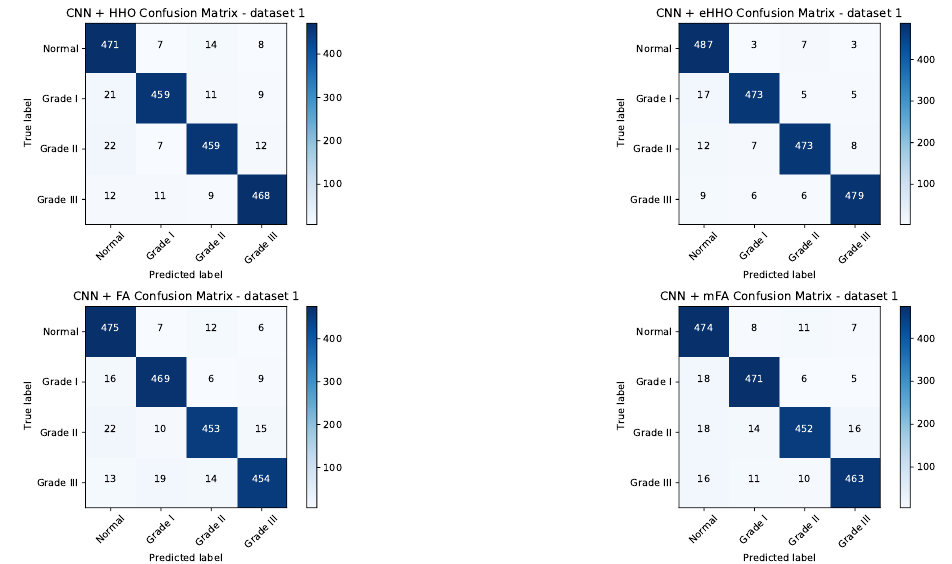
Figure 9. Confusion matrix for dataset1 with a direct comparison between proposed eHHO, HHO, FA and mFA approaches.